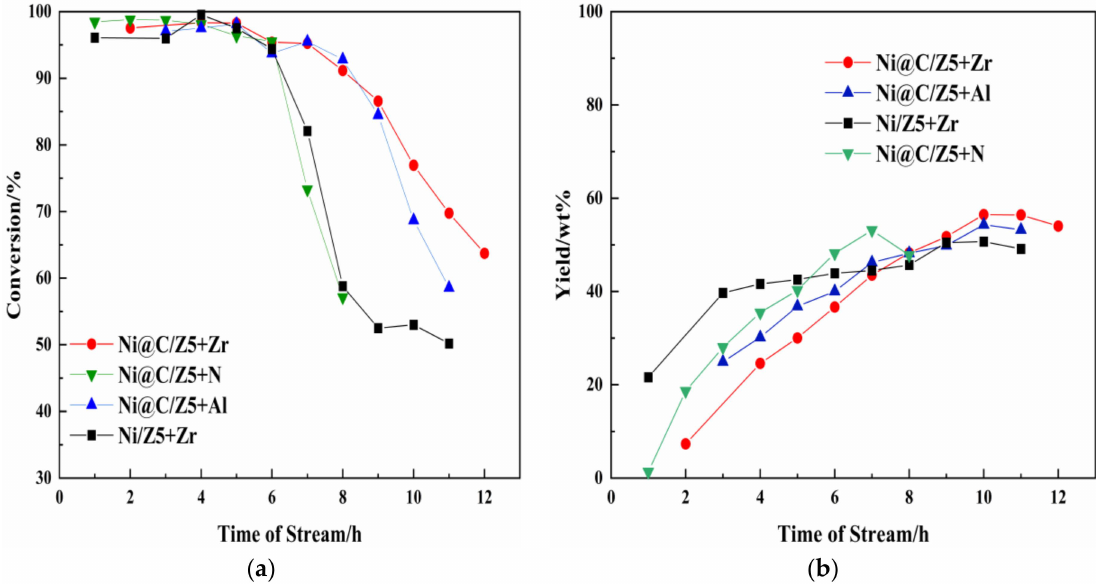
Figure 4. Time course for conversion ( a ) and yield ( b ) of the C8–C18 hydrocarbons on Ni@C/Z5+Al, Ni@C/Z5+Zr, Ni@C/Z5+N, and Ni/Z5+Zr. Reaction conditions: 370 ◦ C, 4.0 MPa, LHSV = 2.92 h − 1 , H 2 /Feed = 1214